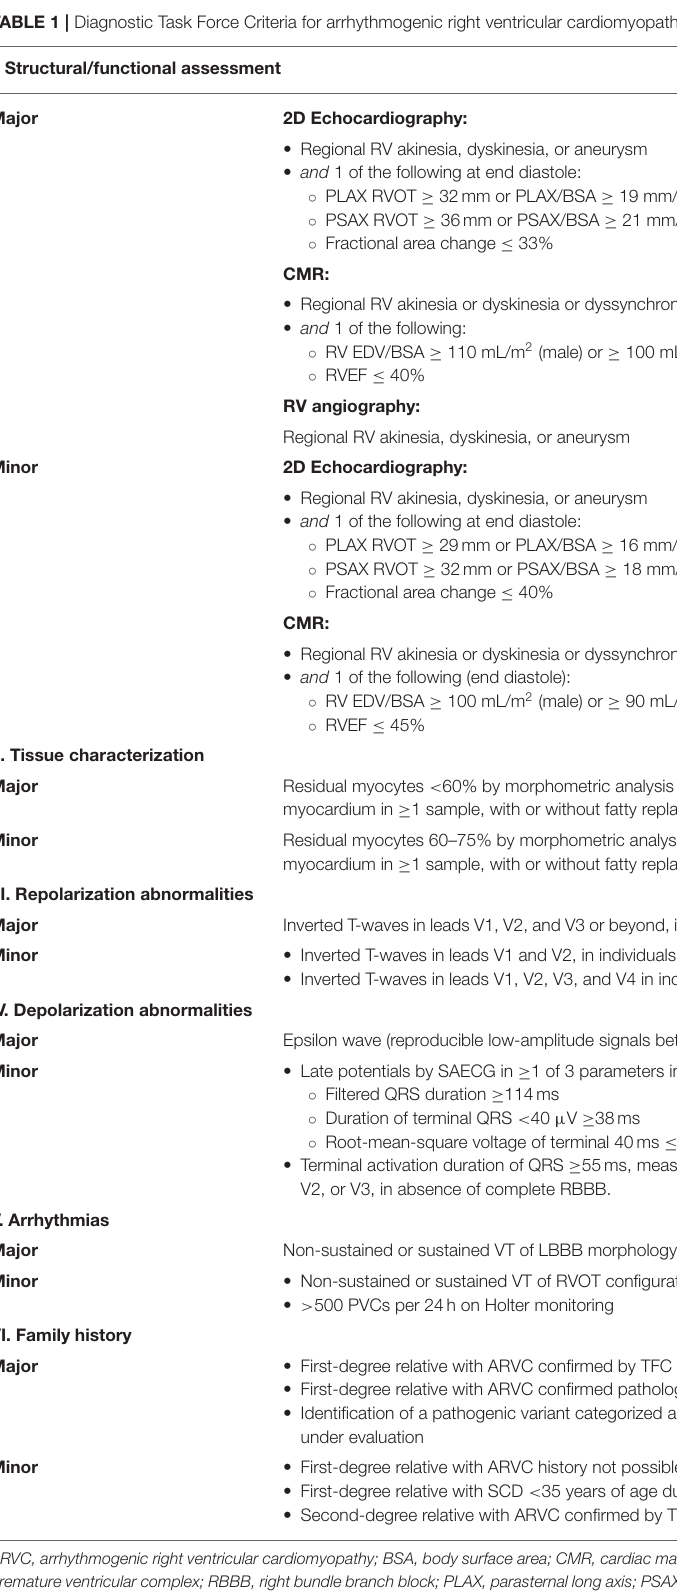
TABLE 1 | Diagnostic Task Force Criteria for arrhythmogenic right ventricular